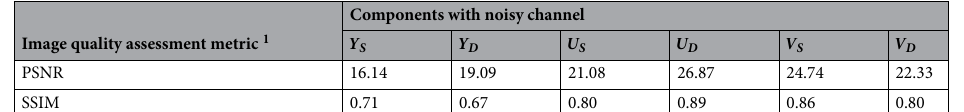
Figure 8. Binary erasure channel.